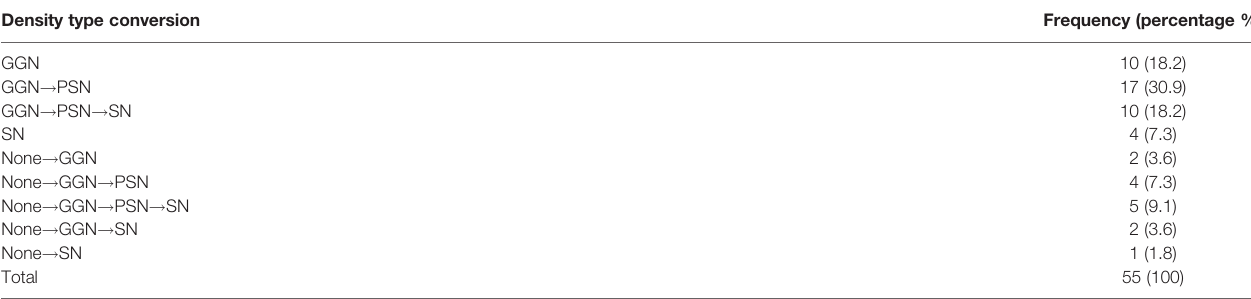
TABLE 3 | The density type conversion during follow-up times.